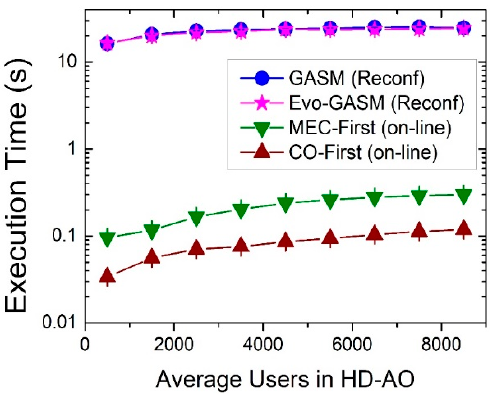
Figure 7. Execution times for basic GASM, evolutive GASM, MEC First and CO First for (cid:2038) = 0.5.